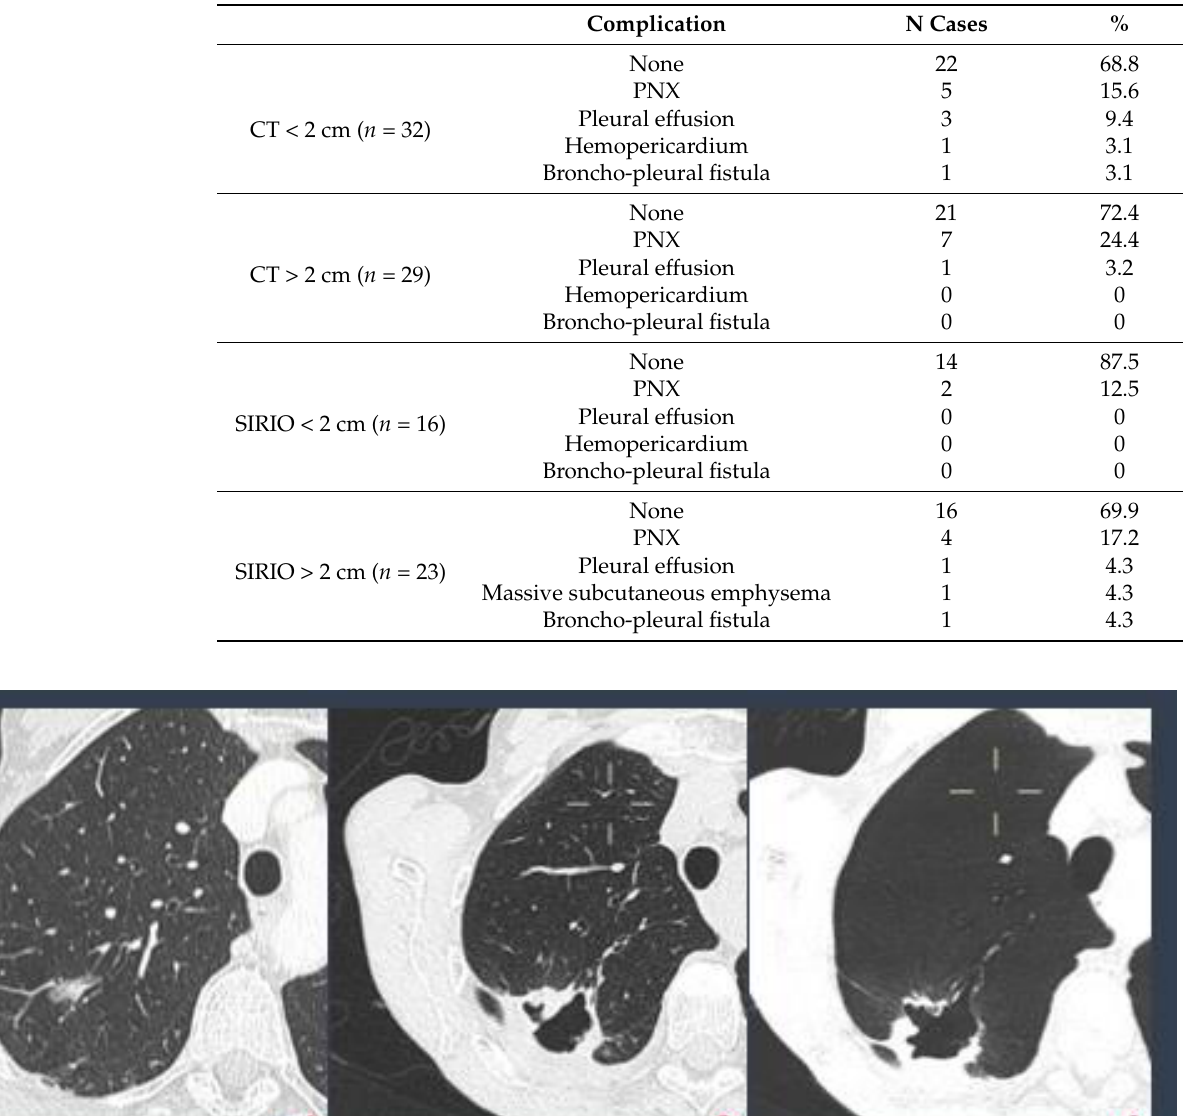
Table 3. Complication types and relative rates.